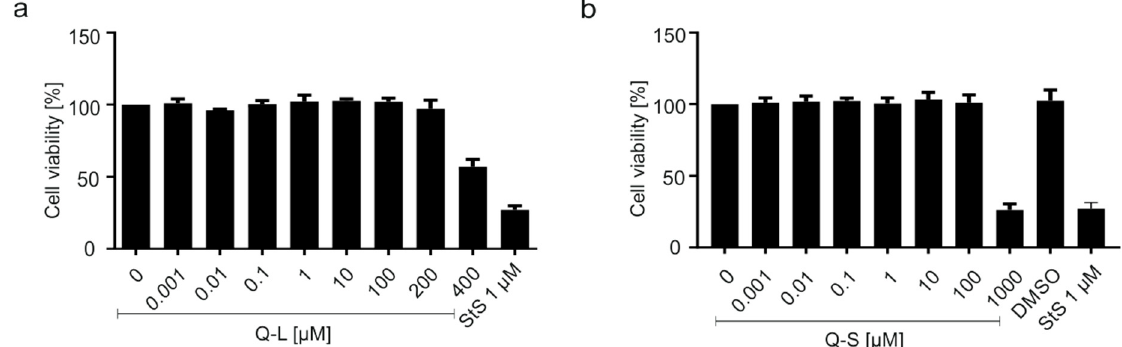
Figure 4. Influence of quinine (a + b) on the cell viability of CaCo-2 cells. Similar to the drug treatment scheme described in Figure 2, the influence on cell viability was measured by WST-1 assays. Quinine-sulfate was used as ( a ) Q-L or ( b ) Q-S. Bars represent mean values of 3 independent experiments ± SD.